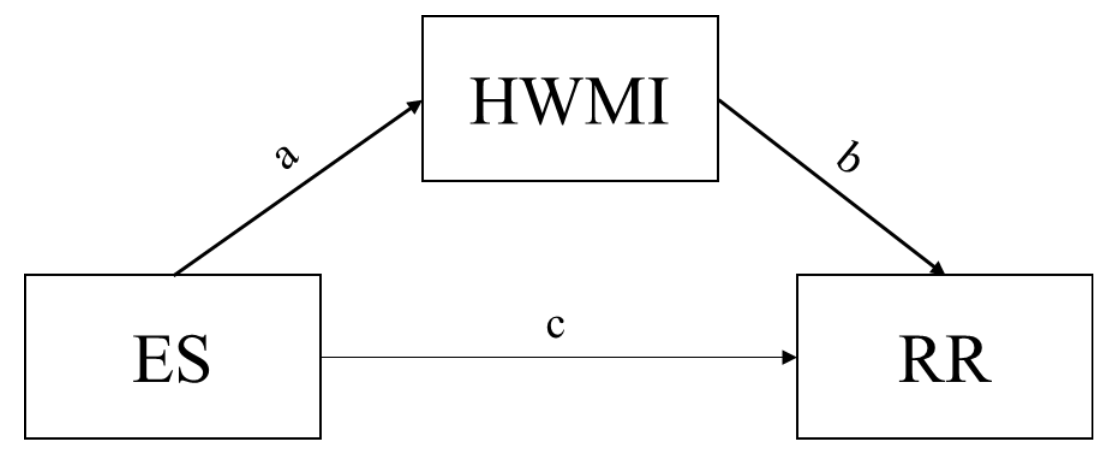
Figure 2. The mediating effect model in this study.